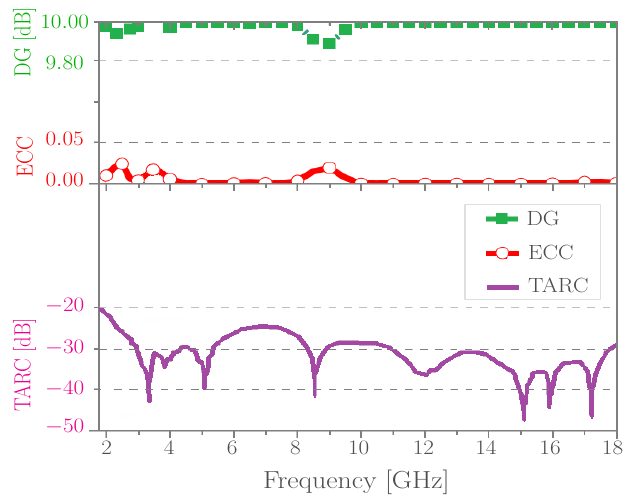
FIGURE 6: Measured ECC, DG and TARC of the proposed MIMO UWB